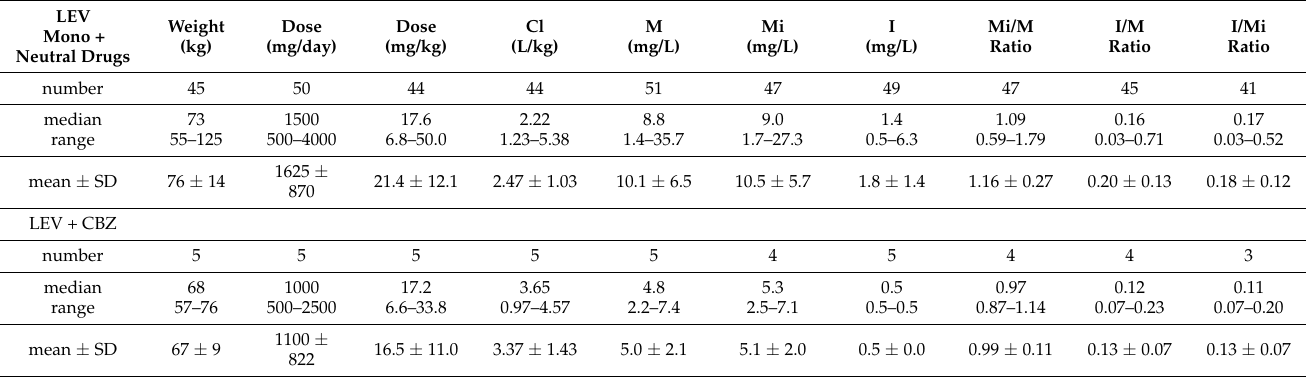
Table 3. Dosage, maternal apparent oral clearance (Cl), maternal serum (M), milk (Mi), and infant (I) serum levetiracetam concentrations and their ratio 2–4 days after delivery in monotherapy (and/or combination with “neutral” drugs) versus combination with carbamazepine